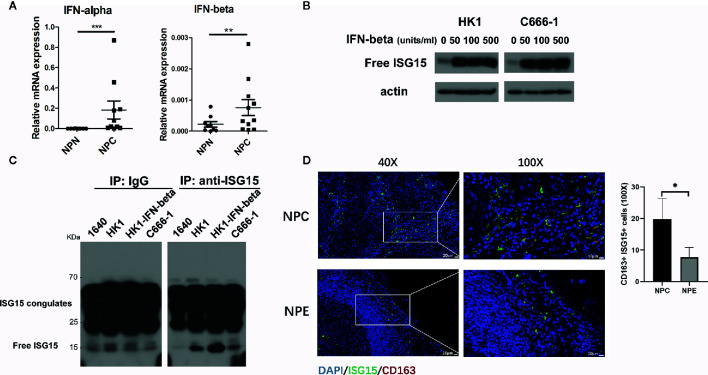
Interferon-stimulated gene 15 (ISG15) is released from nasopharyngeal carcinoma (NPC) cells and functions as a cytokine for macrophages in NPC. (A) Upregulated interferon (IFN)-α and β mRNA were detected in NPC biopsy tissues. (B) Increased ISG15 protein was determined in HK1 and C666-1 NPC cells treated with IFN-β. (C) SDS-PAGE analysis of immunoprecipitated free ISG15 protein from conditional media (CM) of NPC cells. Control as RPMI-1640 CM, and HK1-IFN-β as HK1 cells treated with 50 unit/ml IFN-β for 16 h, and C666-1 as EBV-positive NPC cells. (D) Representative confocal images showing double staining of ISG15 and CD163+ in NPC and non-cancerous nasopharyngeal epithelium (NPE) sample (left panel). Scale bars, 20 μm in 40X or 10 μm in 100X. The quantification of the number of ISG15+ CD163+ cells in NPC (n=6) and in NPE (n=3) (right panel). Data are expressed as mean ± SD. Statistical significance was calculated using two-tailed Student’s t test and is indicated by *p < 0.05, **p < 0.01, and ***p < 0.001.